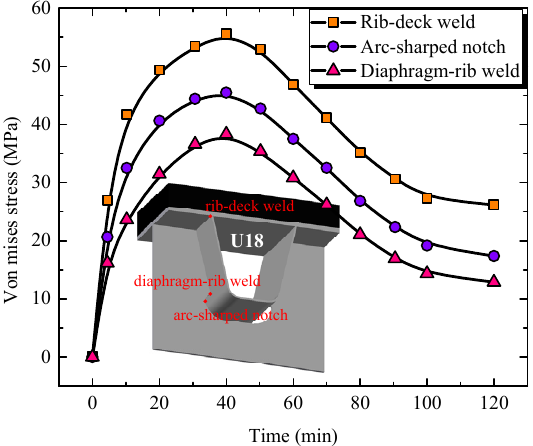
Figure 16. Variation of the stress at fatigable welds during the paving process.